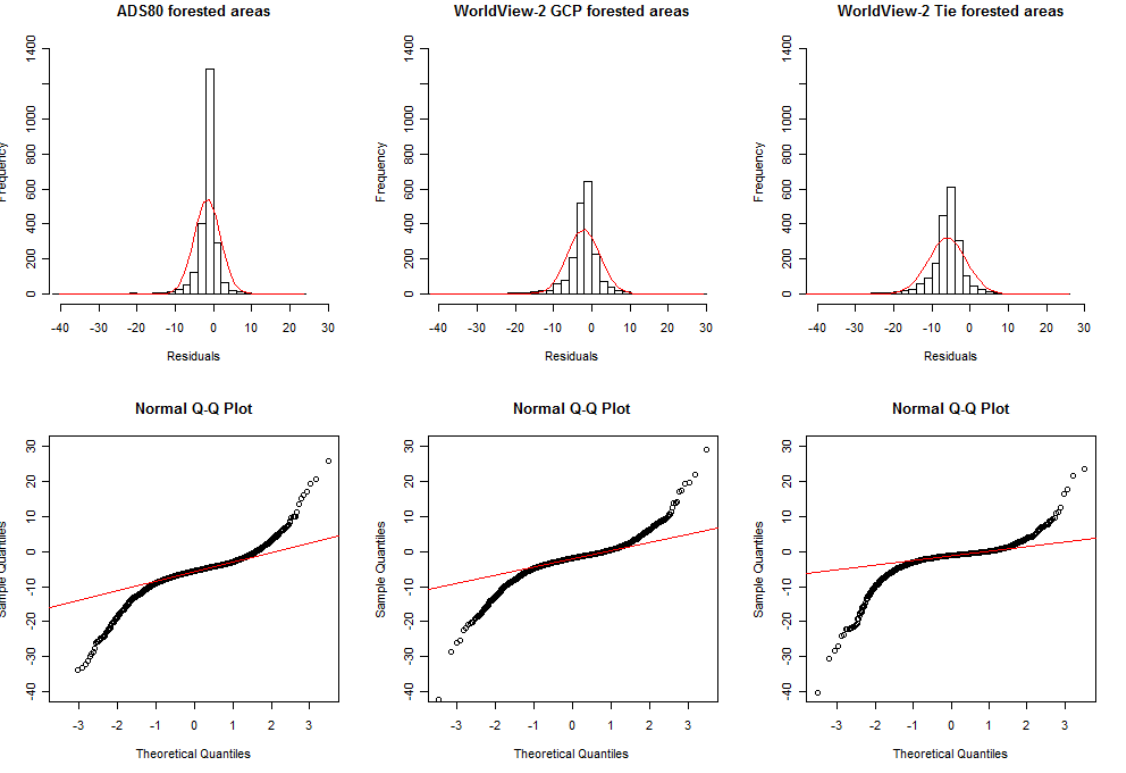
Figure 3. Non-normal error distribution from the comparison of the three DSMs with stereo-measurements in the forested areas. Histograms with superimposed normal distribution and normal Q-Q